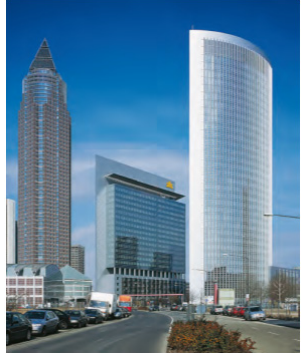
Fig. 2 Structural sealant glazing system – insulation glass unit adhesively bonded to the building substructure (ETAG 002